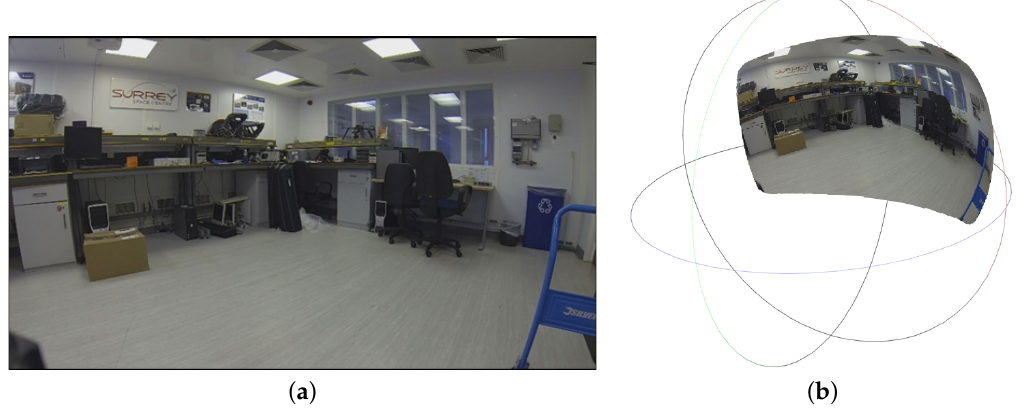
Figure 7. Image of an indoor laboratory environment illustrated as a flat array ( a ); and projected onto a unit sphere using its intrinsic lens model ( b